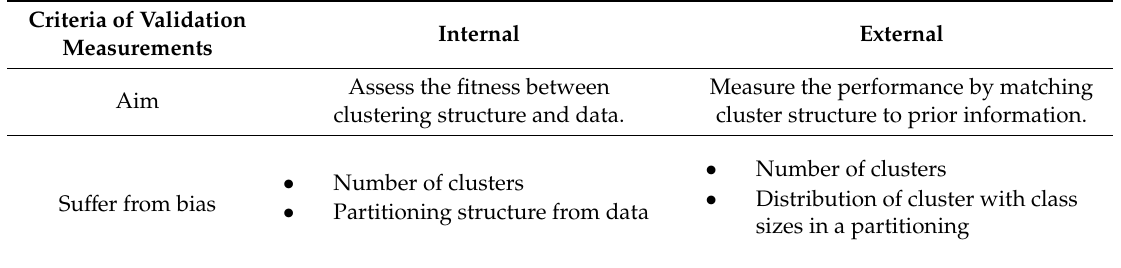
Table 6. The di ff erence in measurements between internal and external validations.